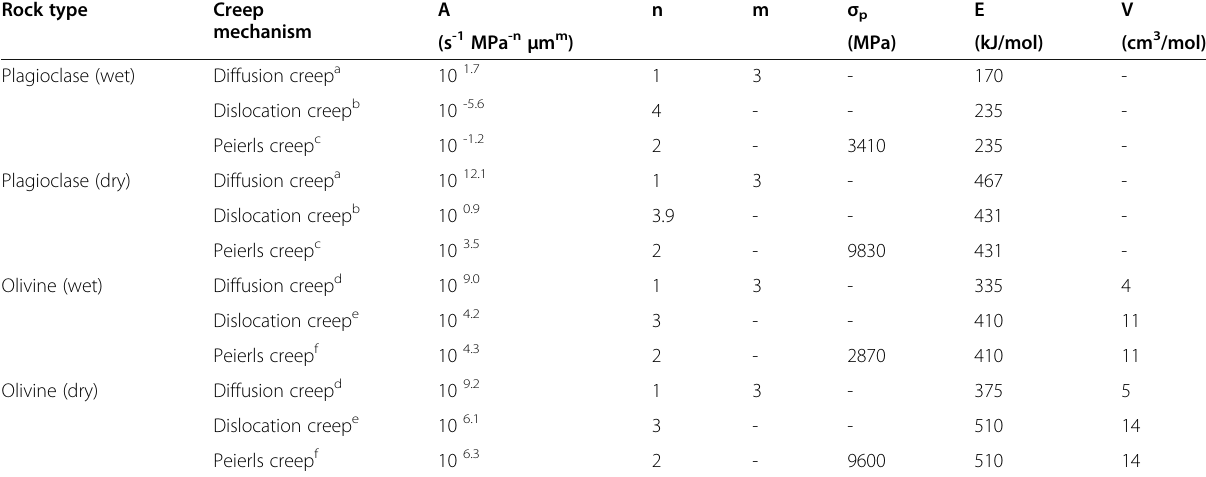
Table 2 Flow law parameters used for calculation of rhelogical structures Rock